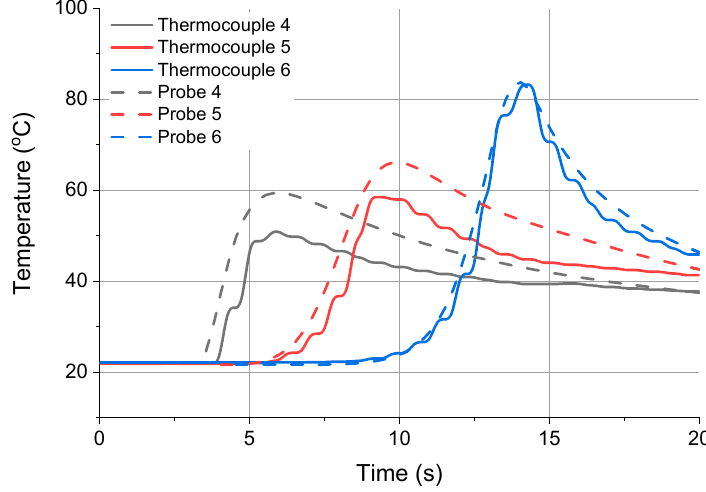
Figure 16. Measurement results compared with the numerical simulation data obtained using Ansys Workbench.